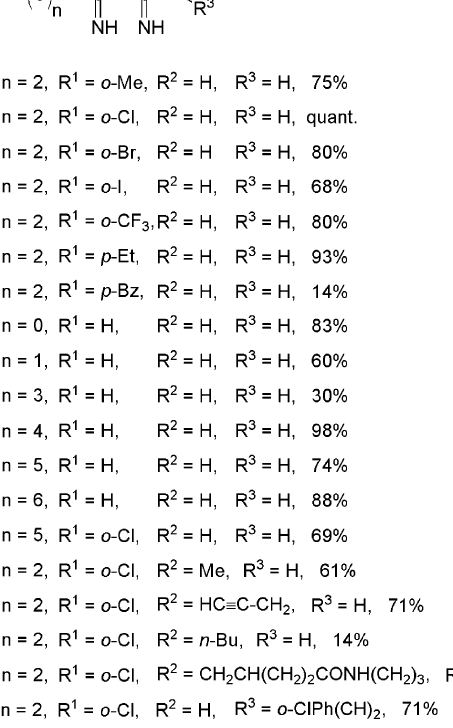
Figure 2. Synthesis of a series of biguanides via microwave-assisted reactions. Reagents and conditions: (a) dicyandiamide, TMSCl,